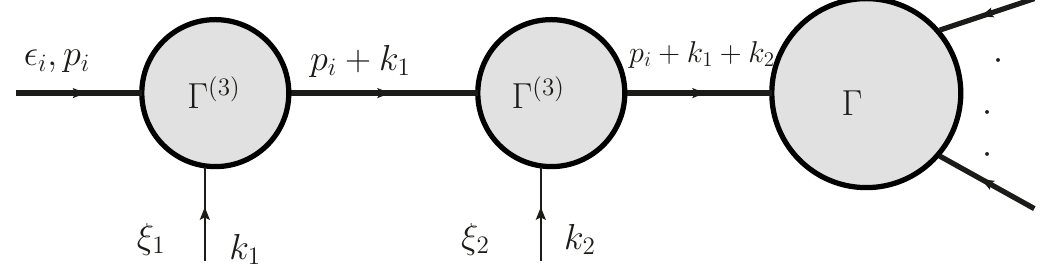
Figure 7 . Diagram with two soft particles attached to same leg start contributing at leading order in soft